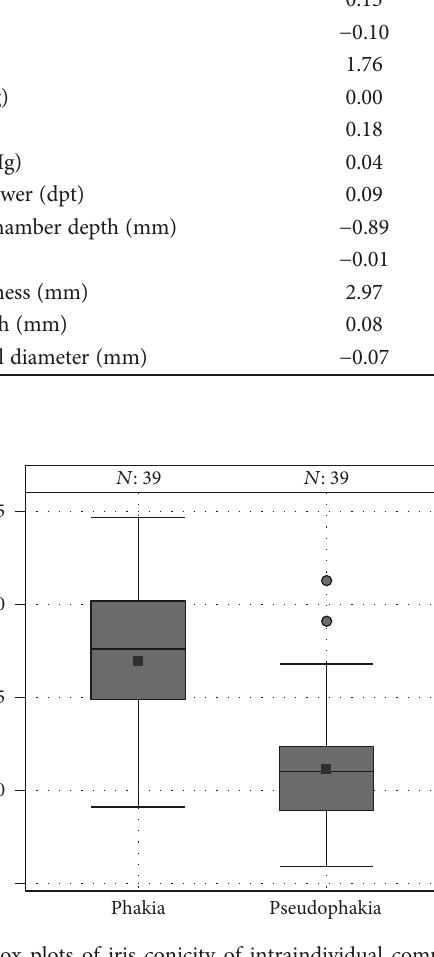
Figure 3: Box plots of iris conicity of intraindividual comparison of phakic and pseudophakic eyes in the GHS study population ( N is the number of subjects with one eye having pseudophakia and the fellow eye being phakic in our study